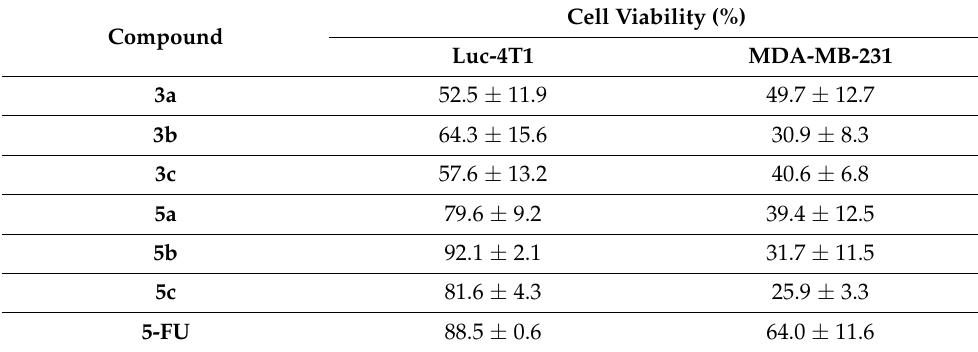
Table 1. SRB screening for six chalcone compounds on mouse and human breast cancer cell